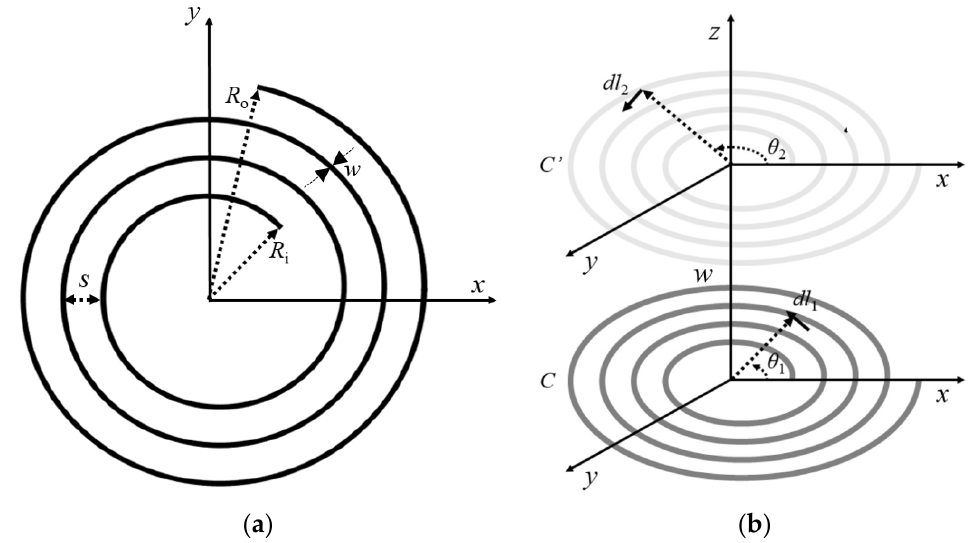
Figure 1. ( a ) Archimedean spiral coil. ( b ) Archimedean spiral coil with its mirror